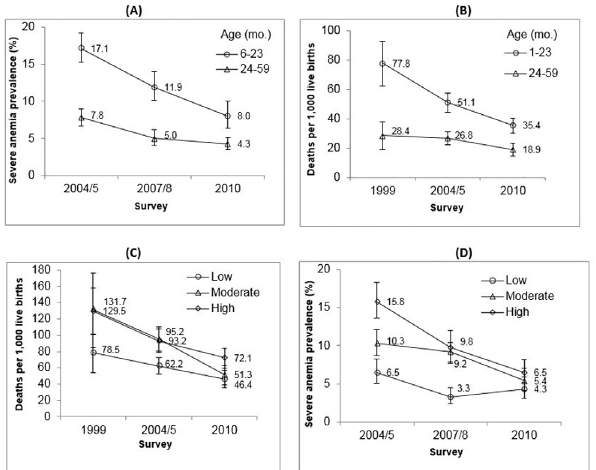
Fig 4. Severe anemia prevalence and all-cause mortality (deaths per 1000 live births) according to age group (A) and (B) and malaria endemicity (C) and (D), respectively.